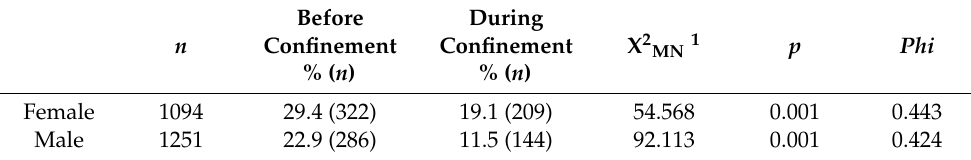
Table 3. Proportion of risky alcohol consumption by gender before and during confinement.